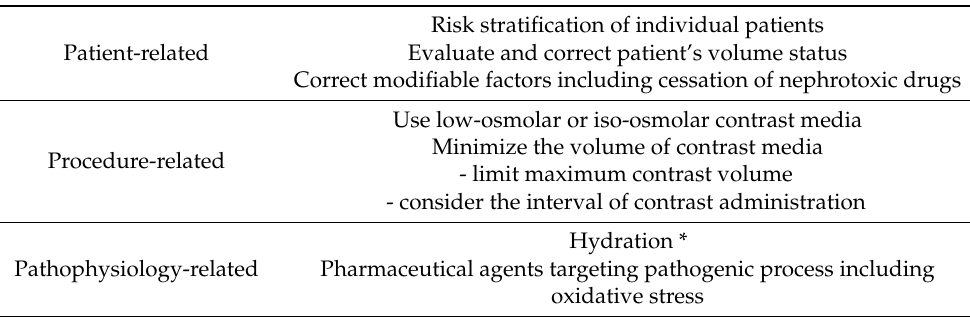
Table 2. Strategies to reduce the development of contrast-induced nephropathy. Preventive strate- gies against contrast-induced nephropathy (CIN) are presented, taking into account patient- and procedure-related risk factors and CIN pathophysiology. * Hydration is a patient-, procedure-, and pathophysiology-related preventive strategy against